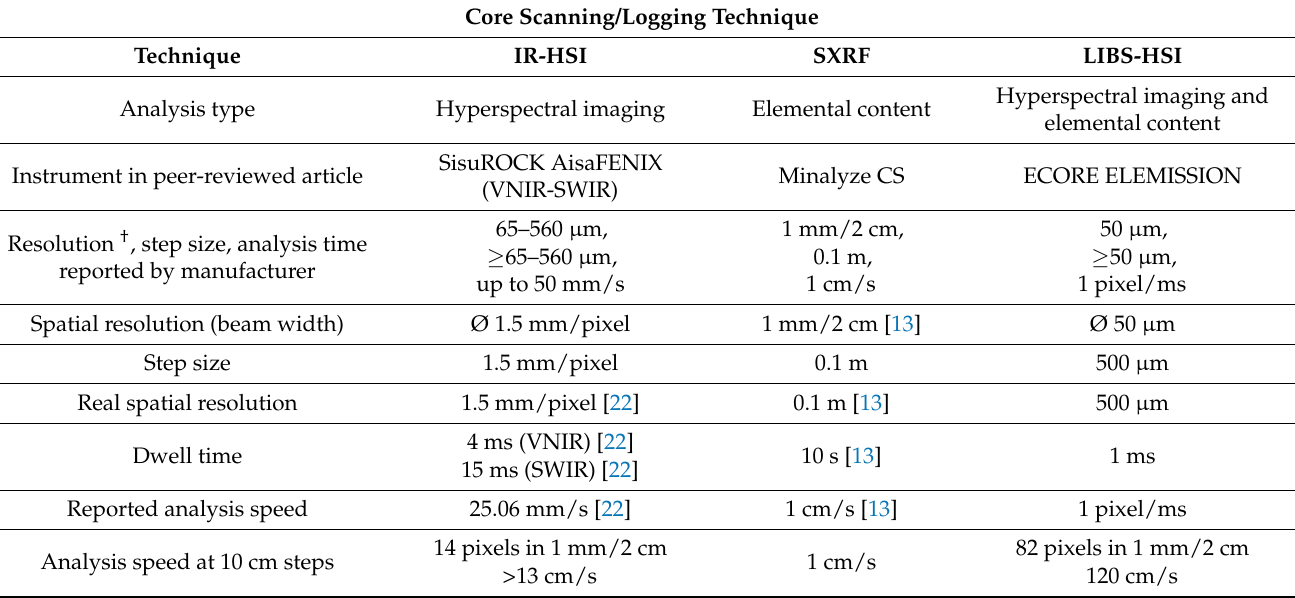
Table 1. Comparison of LIBS parameters with IR-HSI (low-speed IR analysis) and with SXRF (high-speed SXRF core logging) parameters taken from peer-reviewed